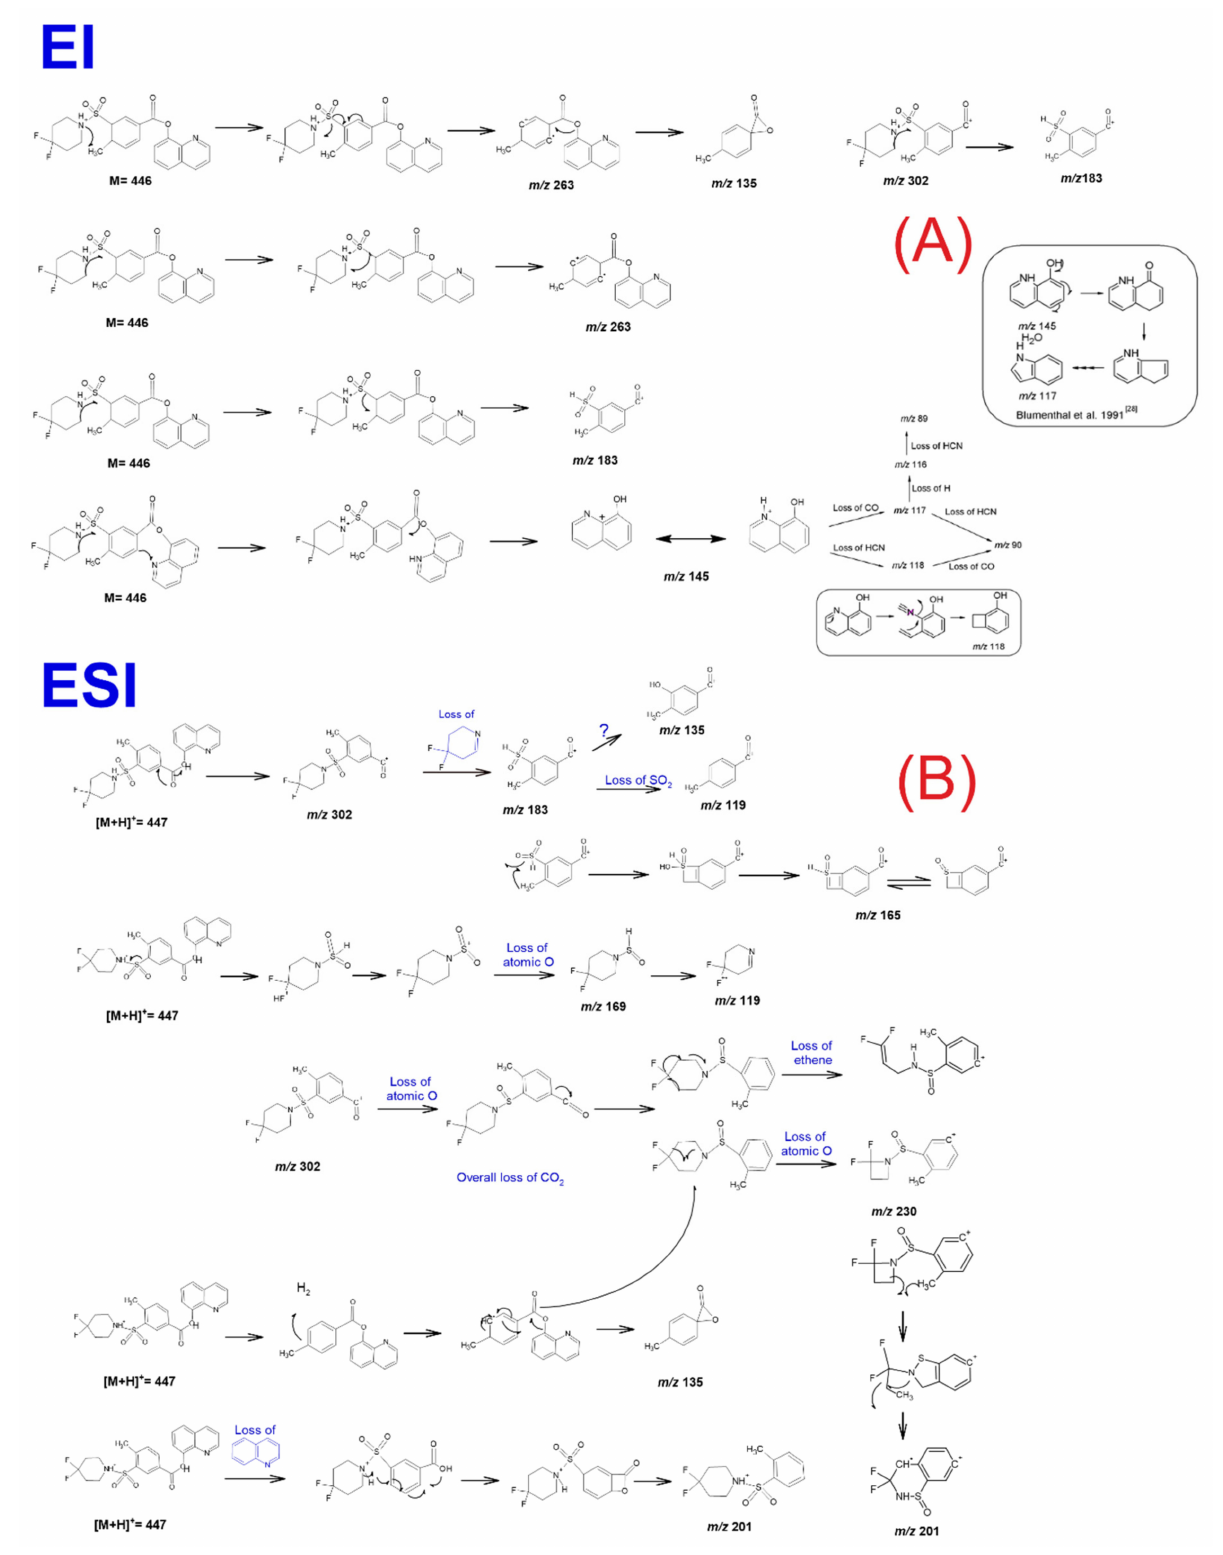
Figure 7. GC-EI-MS ( A ) and UHPLC-ESI HR-MS ( B ) suggested fragmentation schemes for identified NPS 2F-QMPSB. The formation of arylsulfinamide, or the elimination of the SO 2 , could be enhanced by neighboring group participation, such as the N-S (Figure 7B). It should also be highlighted that the SO 2 rearrangement pathway, in the positive mode, is less predictable